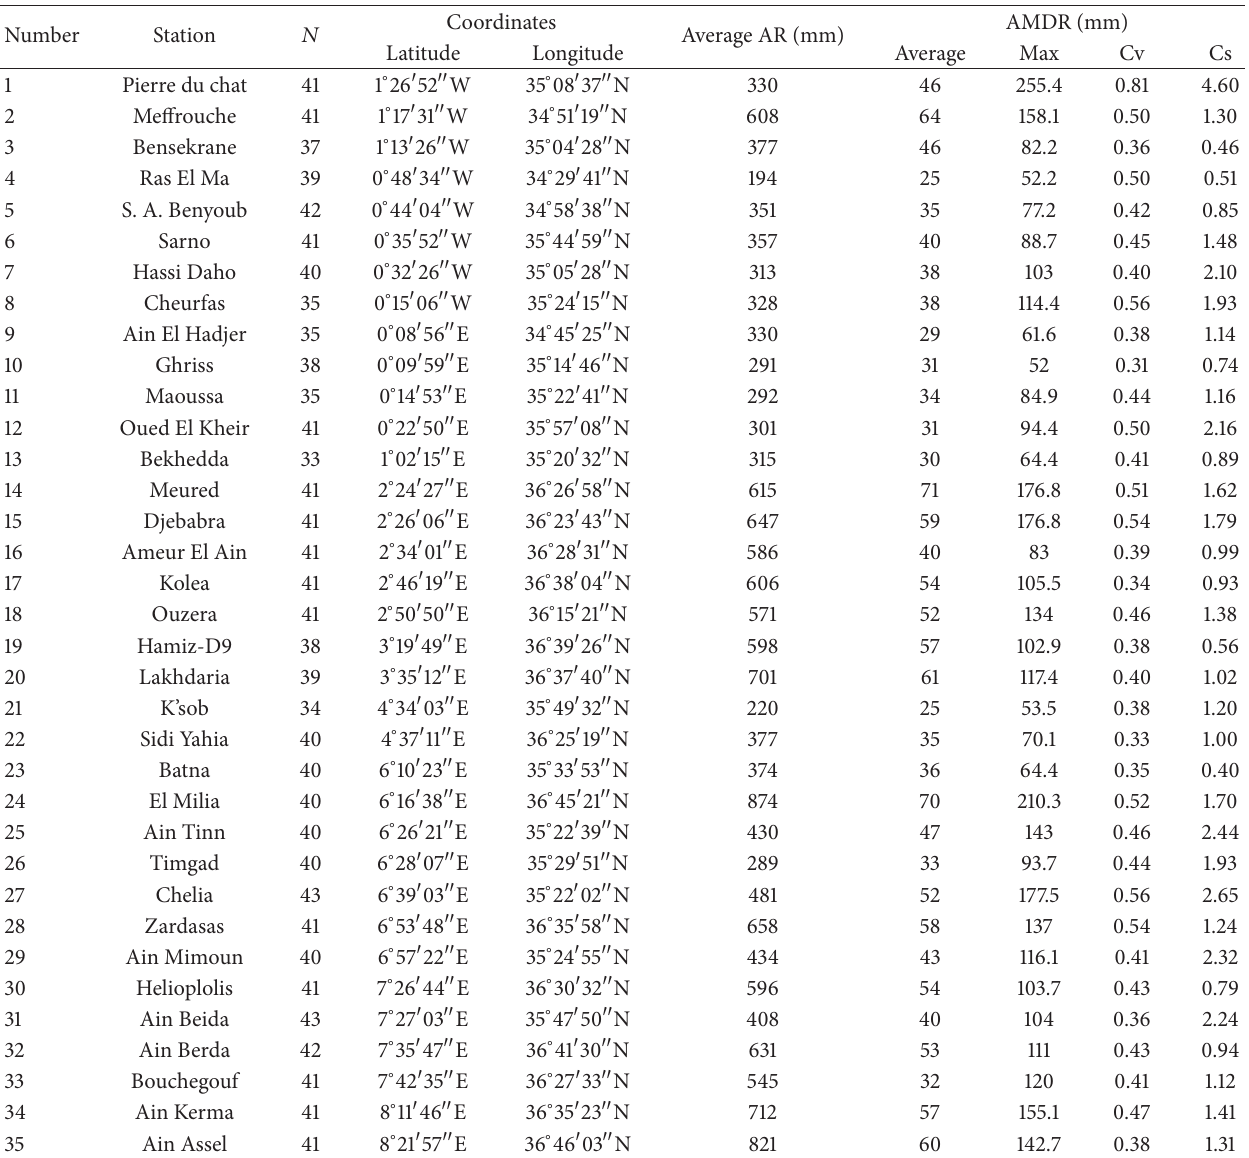
Table 1: Descriptive statistic of AMDR in northern